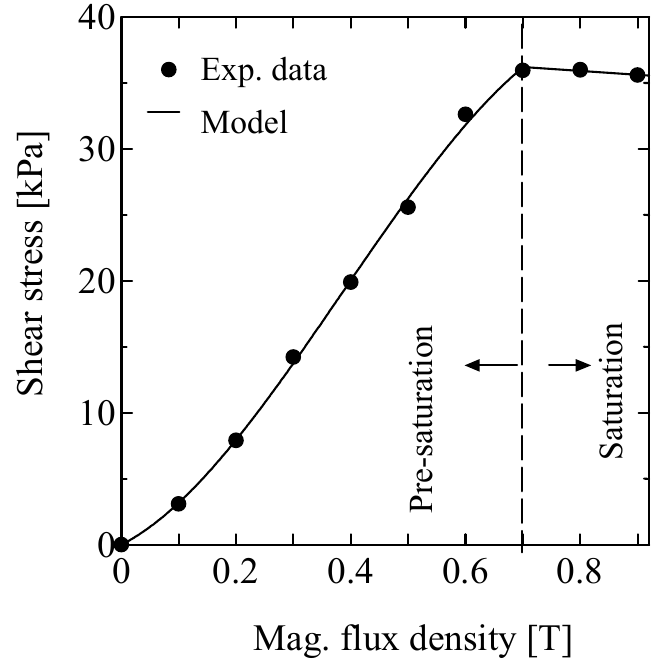
Figure 12. Flow characteristics of the sample material.